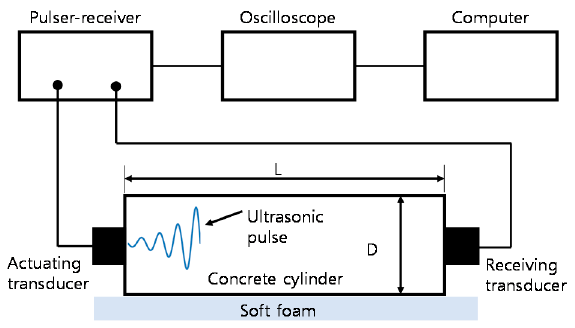
Figure 3. Test setup for ultrasonic pulse velocity measurements.